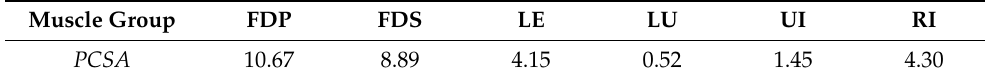
Table 1. Finger PCSA parameters (cm 2 ).